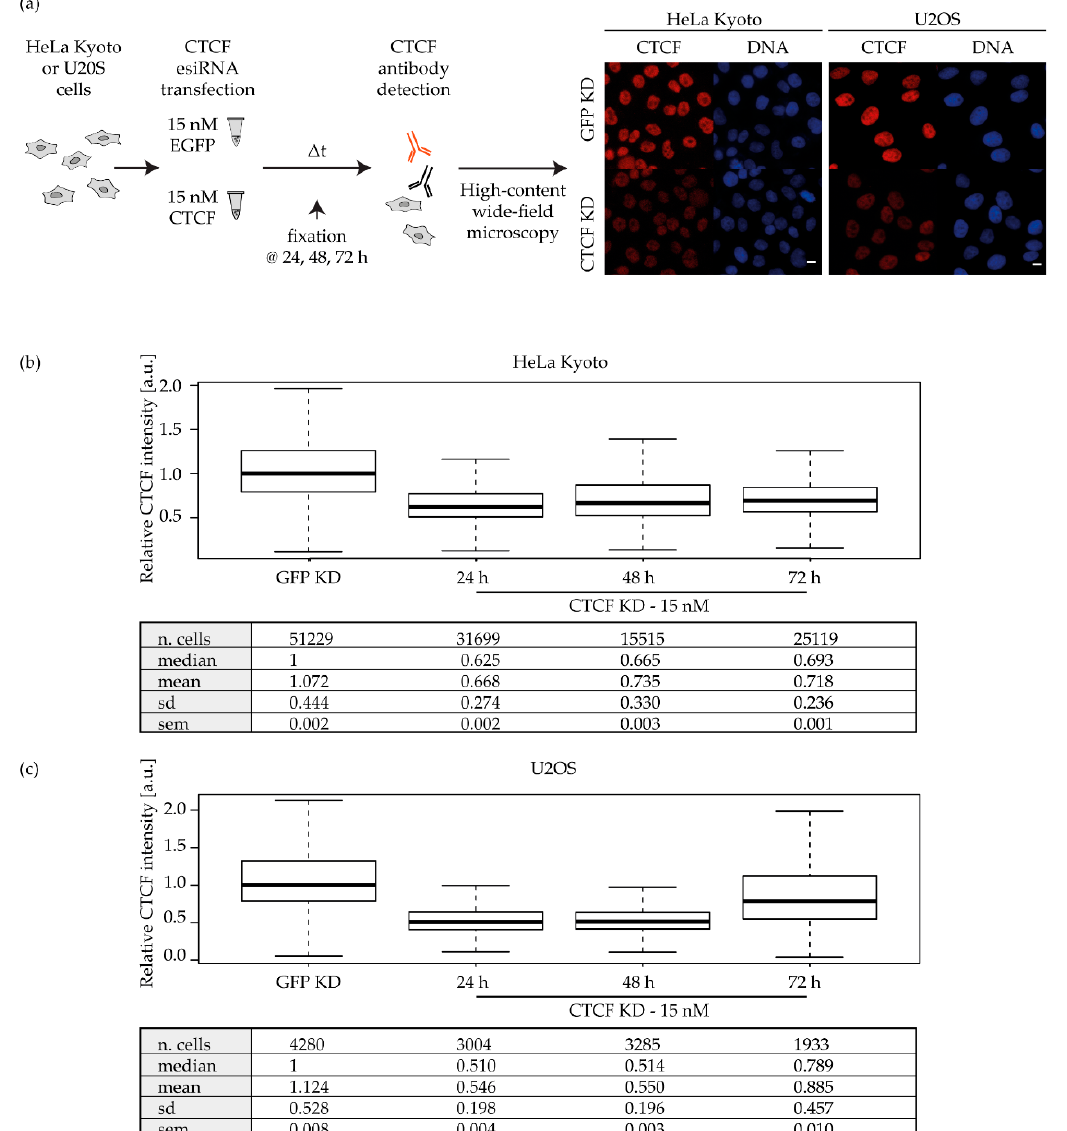
Figure 2. CTCF knockdown is efficiently achieved in 24 h in HeLa Kyoto and U2OS. ( a ) Experimental settings for the knockdown validation. HeLa Kyoto and U2OS cells were transfected with 15 nM of esiRNA against either the human CTCF transcript or EGFP through electroporation and seeded on coverslips. Cells were fixed at 24, 48, or 72 h post transfection and immunostained for CTCF (Table S2). Cells were imaged using a high-content wide-field microscope (scale bar 10 µm; Table S3). ( b , c ) Relative CTCF nuclear intensity at different time points upon esiRNA transfection in HeLa Kyoto ( b ) and U2OS ( c ). From the high-content microscopy images, nuclei were masked based on the DAPI signal and the CTCF nuclear intensities were measured (see Figure S1). The integrated sum intensity values were then normalized to the values of the mock-depleted GFP KD sample and plotted as boxplots (sd = standard deviation; sem = standard error of mean); the results consist of three biological replicates (Table S4). See Figure S3 for the boxplot interpretation.